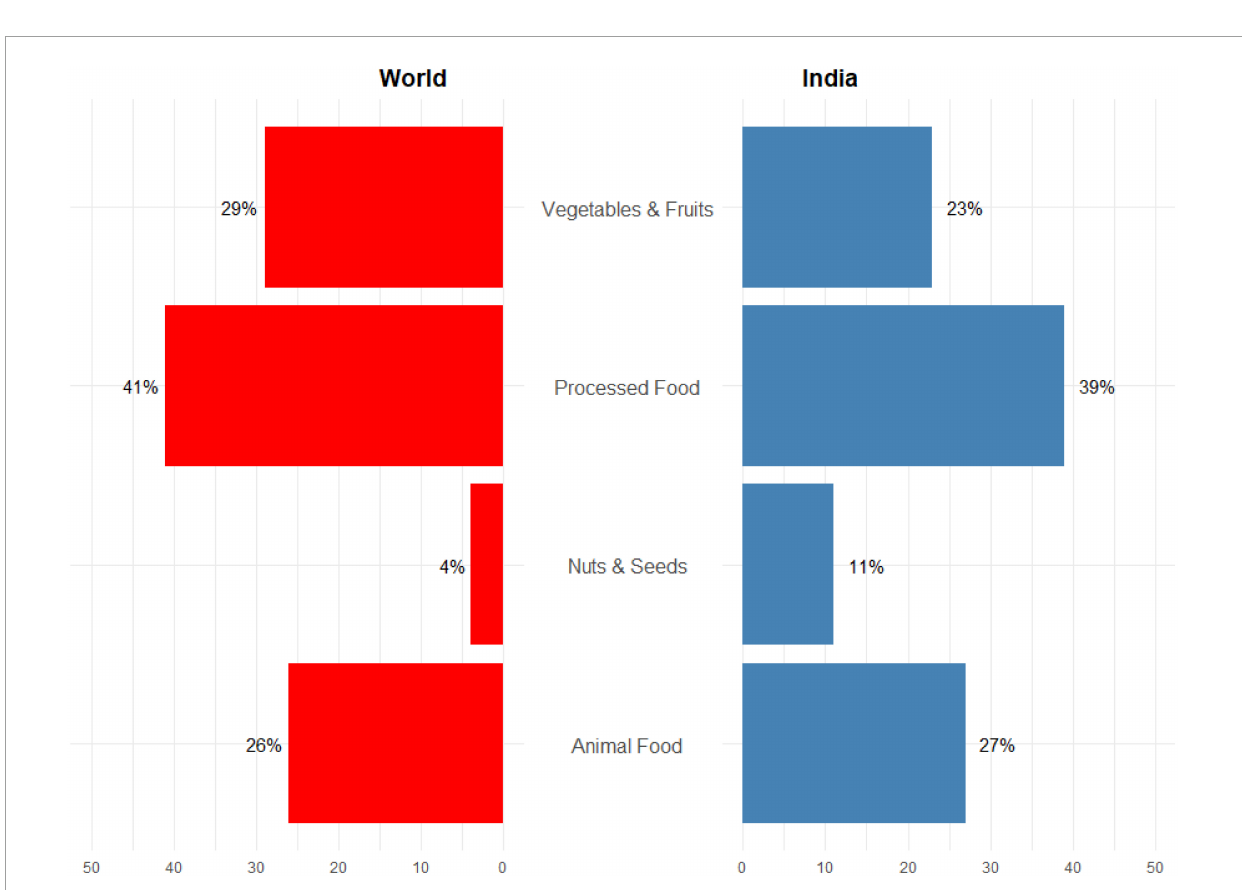
FIGURE2 Components of food consumed by Indians and the world population (https://www.fao.org/3/ca9692en/online/ca9692en.html).